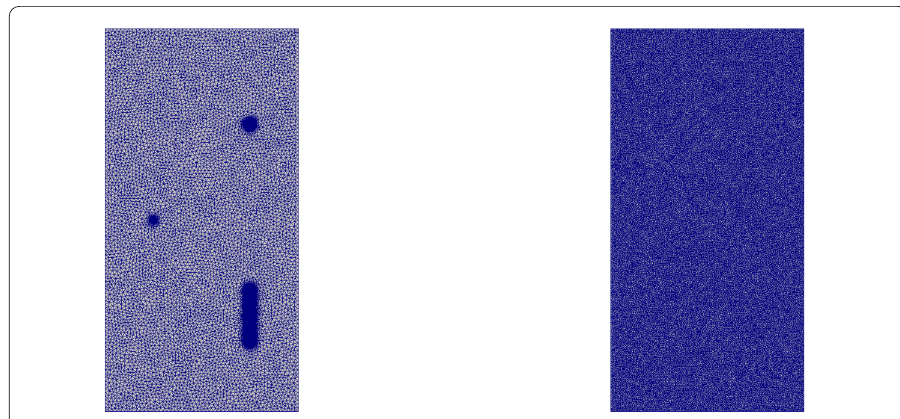
Figure 4 Meshes. Left: mesh corresponding to the faulty plate. Right: mesh corresponding to the healthy plate. Both meshes have approximately the same number of nodes, however for the faulty plate, these are concentrated near the three